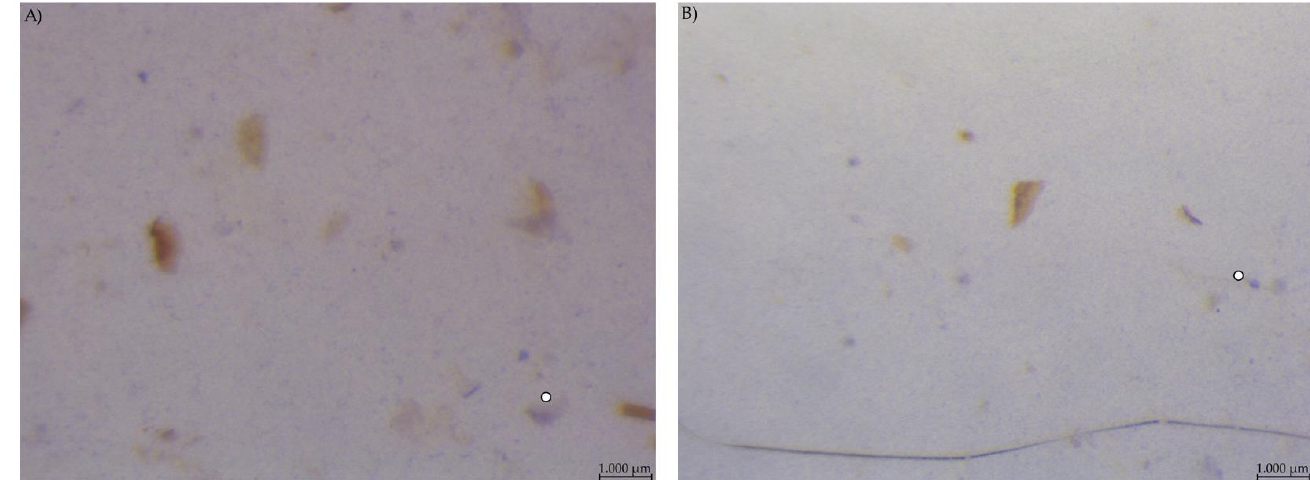
Figure 7. Caecum content stained with Lugol ’ s iodine. ( A ) PEL and ( B ) EXT, both with stained streaks dominating the picture (stereomicroscopy, 25 ×; ○ marking larger fragments of starch).